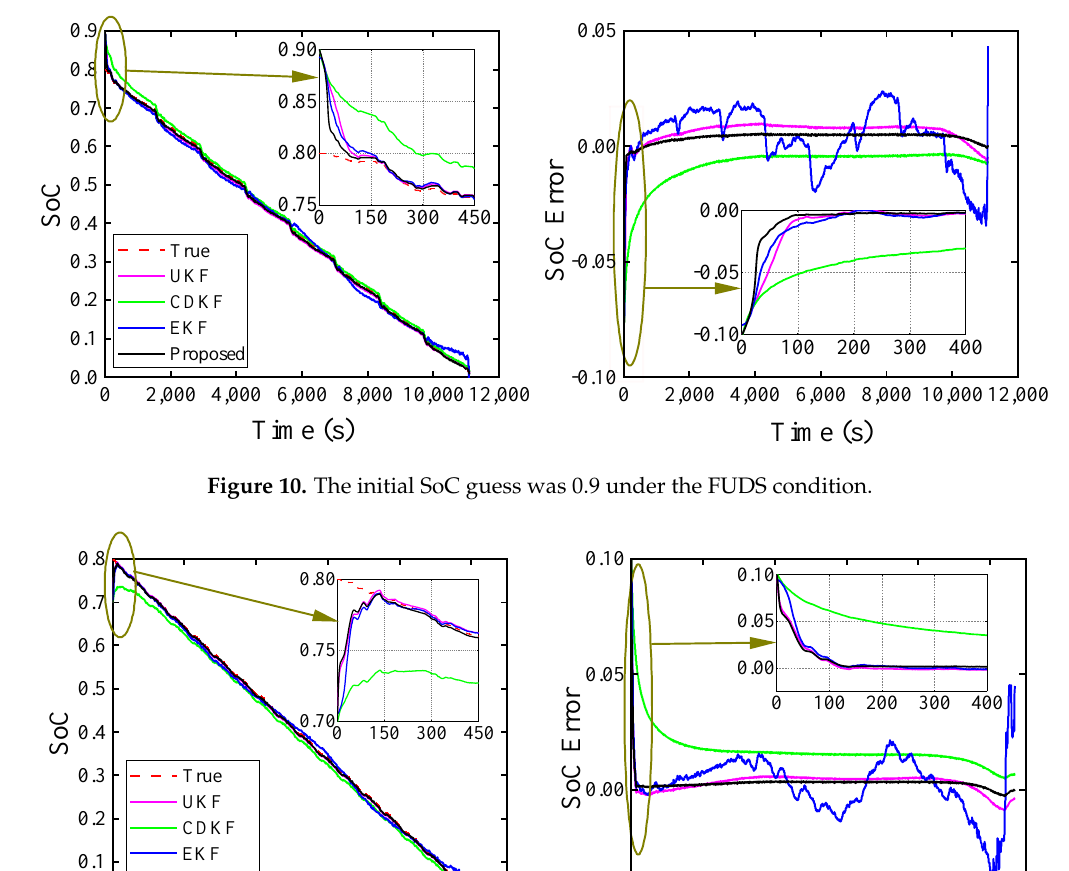
Figure 9. The initial SoC guess was 0.7 under the FUDS condition.